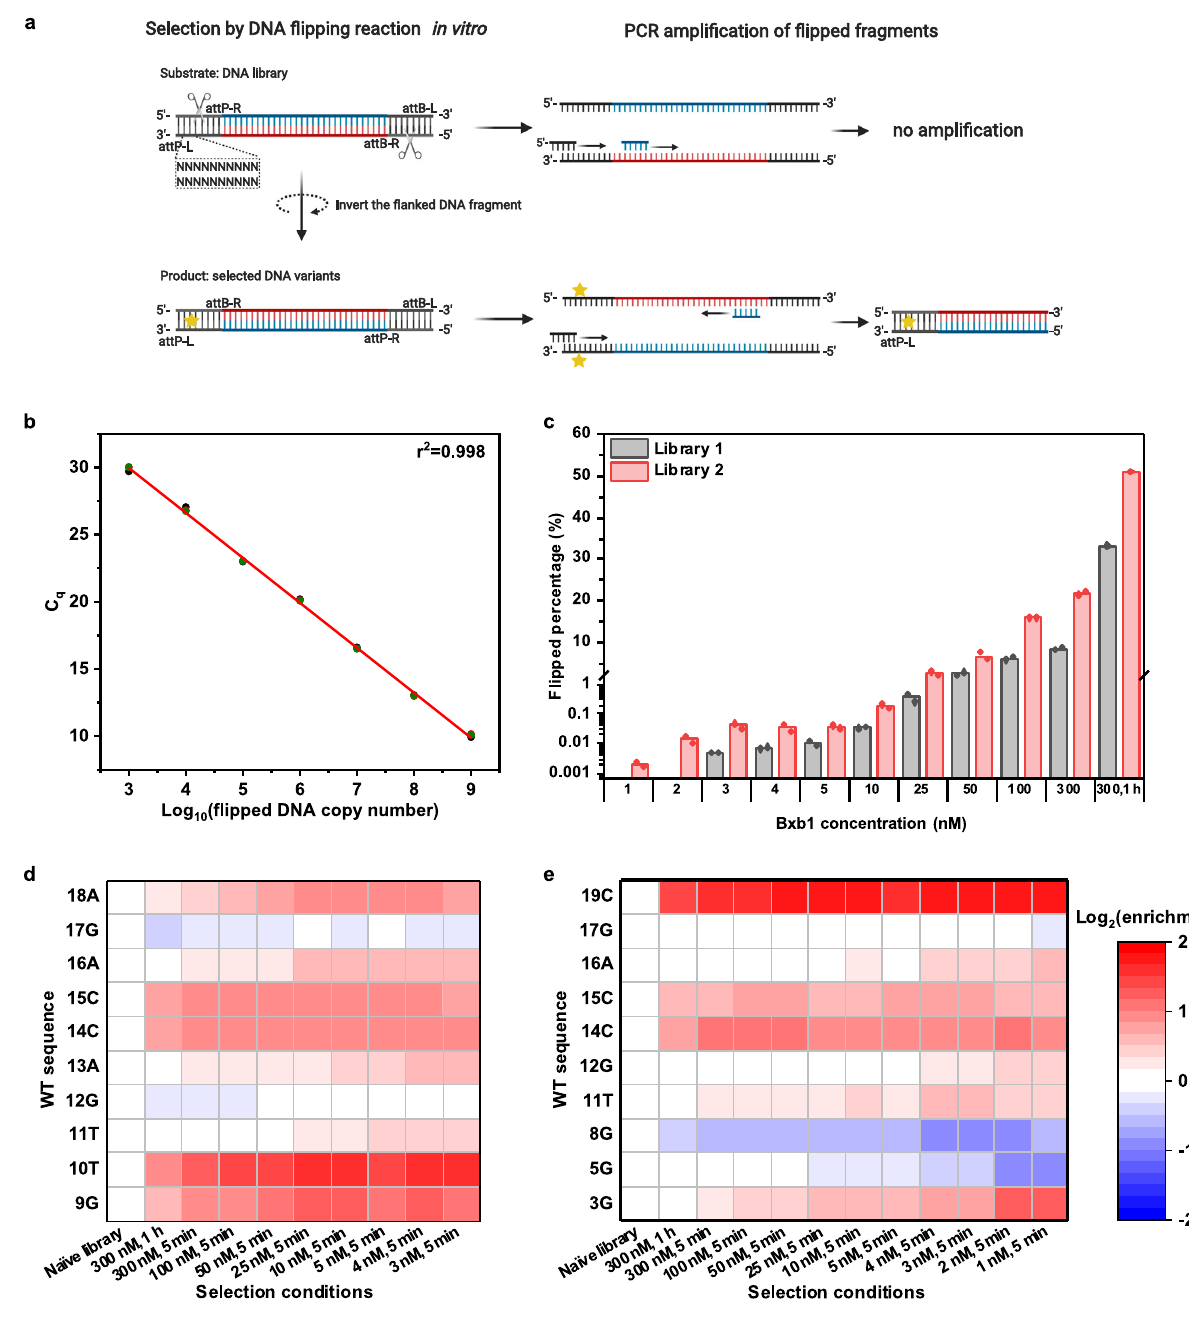
Fig. 2 Quanti fi cation of DNA inversion and attP-L library selections by qPCR. a Library selection procedure. First, a DNA site-saturation library is constructed by designed oligonucleotides with equimolar mixed nucleotides (N) at 10 designated positions (shown as asterisks in Fig. 1f). The 10 consecutive Ns shown here depict library 1; library 2 is conceptually analogous but is not illustrated here. Second, sequences with DNA recombination functionality (yellow star) undergo inversion in the reaction solution. Last, the fl ipped sequences are selectively enriched by qPCR. For fl ipped DNA fragments, the black and blue primers anneal to two different DNA strands, resulting in ampli fi ed products (bottom); for un fl ipped DNA, the primers anneal to the same strand and no PCR product can be ampli fi ed (top). b Standard curve for qPCR quanti fi cation of fl ipped DNA fragments. The templates for qPCR are mixtures of fl ipped and un fl ipped DNA with different ratios and the same total copy number 10 9 (slope = − 3.378, intercept = 40.169, r 2 = 0.998). Three technical replicates were performed. c qPCR quanti fi cation of DNA library fl ipping. Bxb1 at concentrations varying from 1 nM to 300 nM was added to the reaction buffer with 10 nM DNA library and then incubated at 30 °C for 5 min. The reaction was terminated by denaturation at 80 °C for 20 min. The sample with 300 nM Bxb1 and incubated for 1 h at 30 °C was considered the reaction with the most permissive conditions. Two biological replicates were performed for all conditions except for the condition of 300 nM Bxb1 and 1 h incubation. d , e Heat maps of wild-type nucleotide enrichment as a function of selection stress, which increases from left to right in each map ( d library 1; e library 2). Figure 2a was created with BioRender.com. Source data are provided as a Source Data fi le.